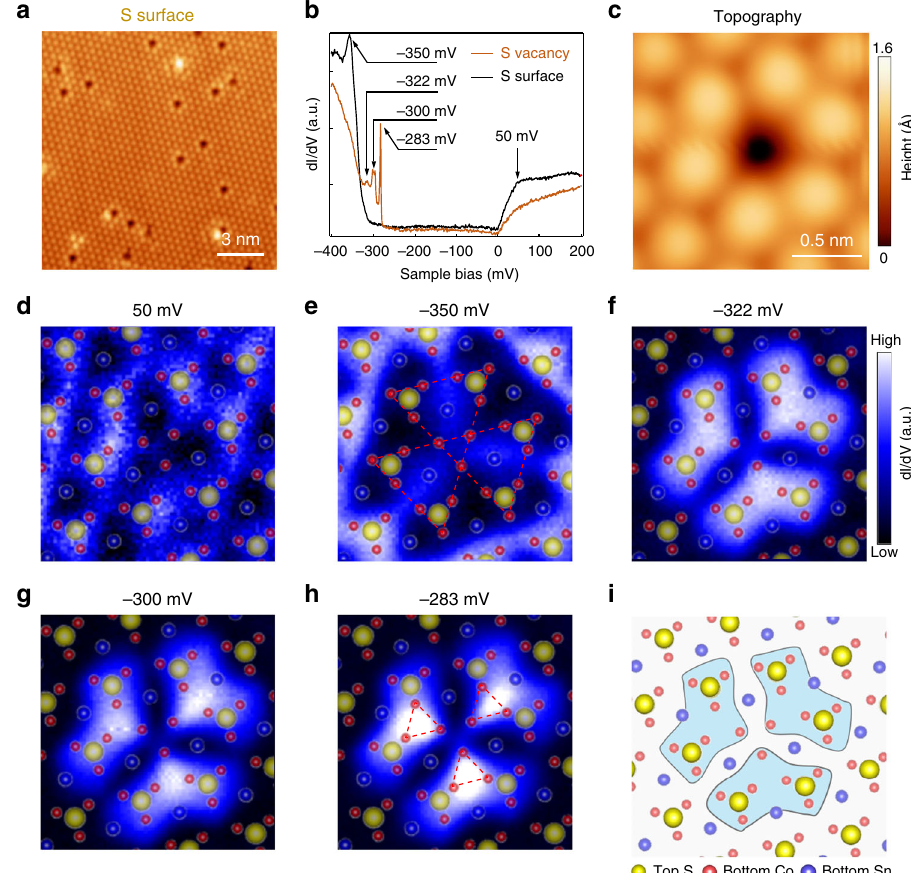
Fig. 2 Localized excitations around a single S-vacancy at the S-terminated surface of Co 3 Sn 2 S 2 . a Atomic-resolution STM image of the S-terminated surface, showing randomly distributed single vacancies (scanning setting: bias: V s = − 400 mV, setpoint I t = 100 pA). b d I /d V spectra at (orange curve) and off (black curve) a single S-vacancy ( V s = − 400 mV, I t = 500 pA, V mod = 0.5 mV). c STM image of a S-vacancy ( V s = − 400 mV, I t = 500 pA). d – h d I /d V maps of ( c ) at different energies: 50 meV ( d ), − 350 meV ( e ), − 322 meV ( f ), − 300 meV ( g ), and − 283 meV ( h ), respectively. Atomic structure of Co 3 Sn 2 S 2 is overlaid on each map, showing the correlation between the atomic structure and pattern in d I /d V map ( V s = − 400 mV, I t = 500 pA, V = 0.5 mV). i Correlation between the atomic structure and the pattern in the d I /d V map in h , showing that the spatial distribution of bound states is mod correlated to the underlying Co atoms. a.u., arbitrary